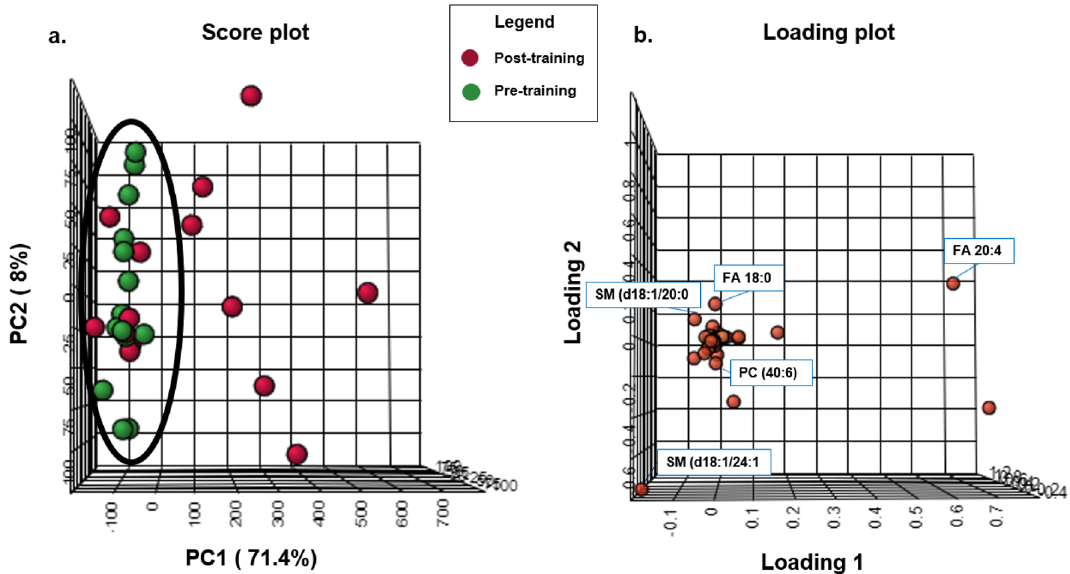
Figure 1. Principal component analysis (PCA). Score plot ( a ) and loading plot ( b ) using the first two principal components obtained from obtained from obese women (n = 14) submitted to combined physical exercise in two moments, pre-training (green) and post-training group (red).